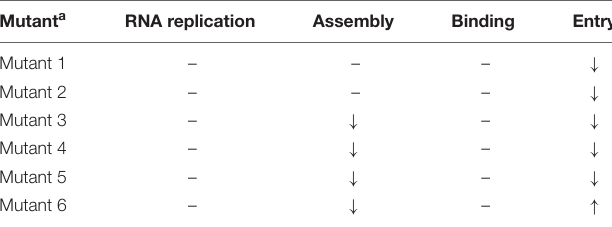
TABLE 3 | Summary of the effects of mutations on virus assembly, RNA replication, binding, and entry a . Mutant a RNA replication Assembly Binding